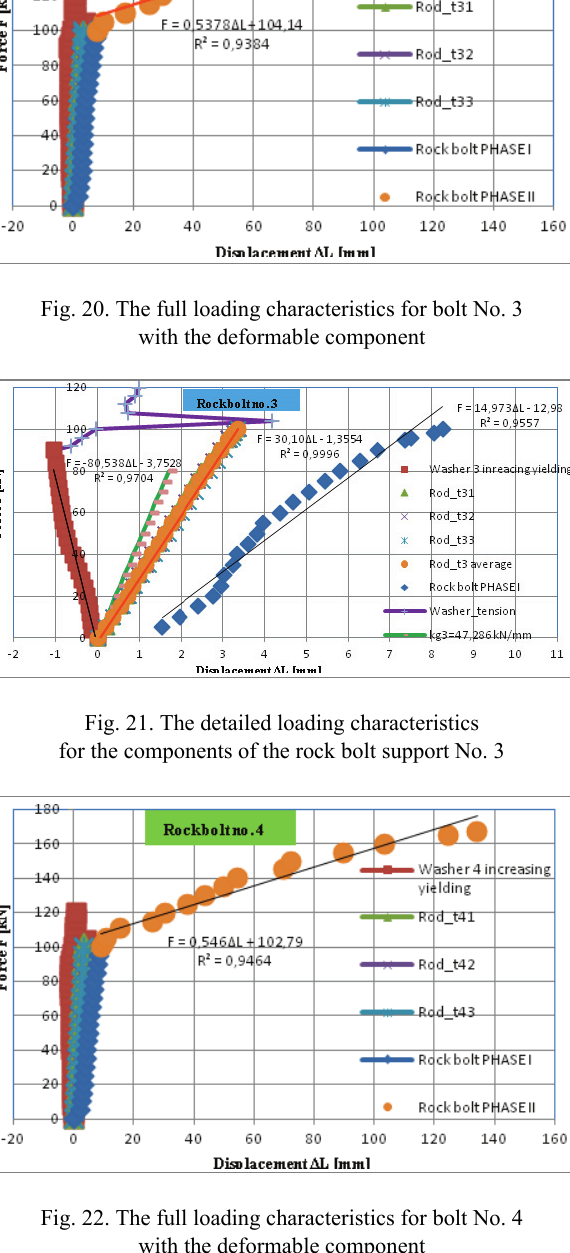
Fig. 22. The full loading characteristics for bolt No. 4